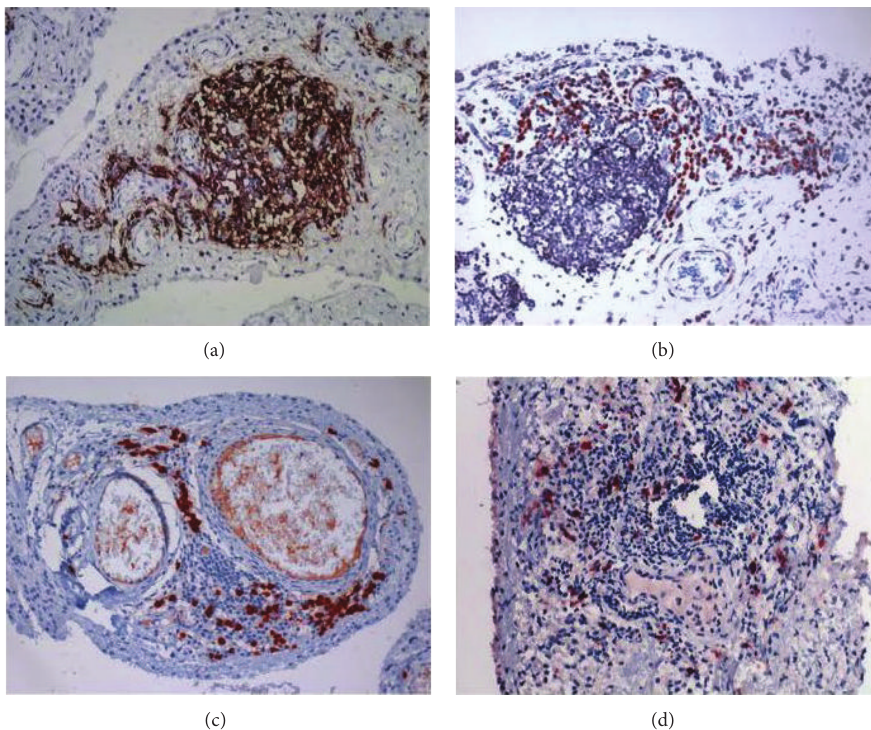
Figure 3: Plasma cells in synovial tissue. (a) CD38 positive plasma cells near lymphocyte follicles in case 5 (DAB staining, 200x); (b) massive IgG-positive plasma cell presence in case 5 (AEC staining, 200x); (c) numerous IgG4-positive plasma cell in case 5 (AEC staining, 200x); and (d) IgG4-positive plasma cells in case 6 (AEC staining,